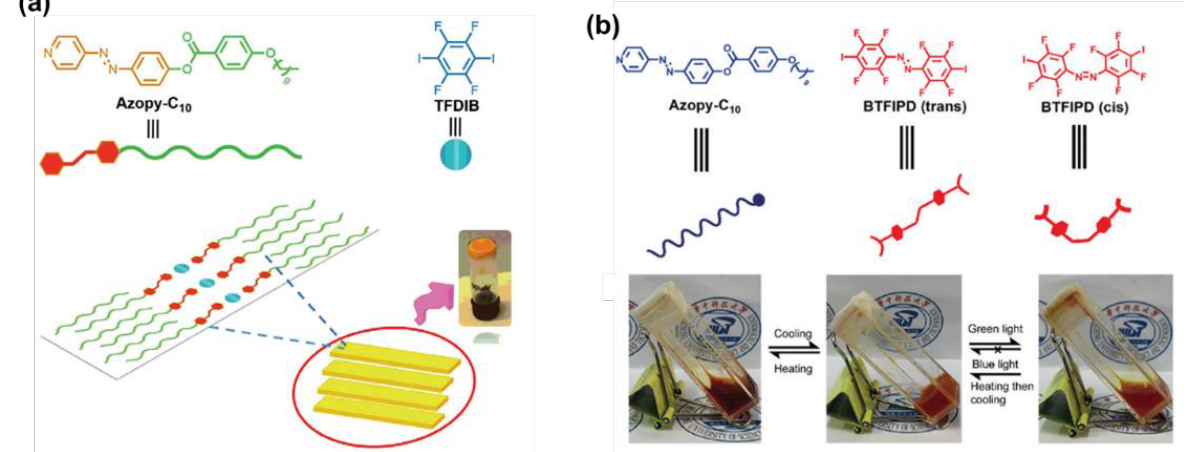
Figure 17. Illustrative strategy for preparing the supramolecular gel driven by X-bond. ( a ) Gel pre- pared from AzPy-C10 and 1,4-tetrafluorodiiodobenzene(TFDIB); Reprinted with permission from [93]. Copyright 2019 Wiley; and ( b ) gel prepared from AzPy-Cn ( n = 8, 10, and 12) and 1,2-bis(2,3,5,6- tetrafluoro-4-iodophenyl)diazene (BTFIPD). Reprinted with permission from [94]. Copyright 2019,